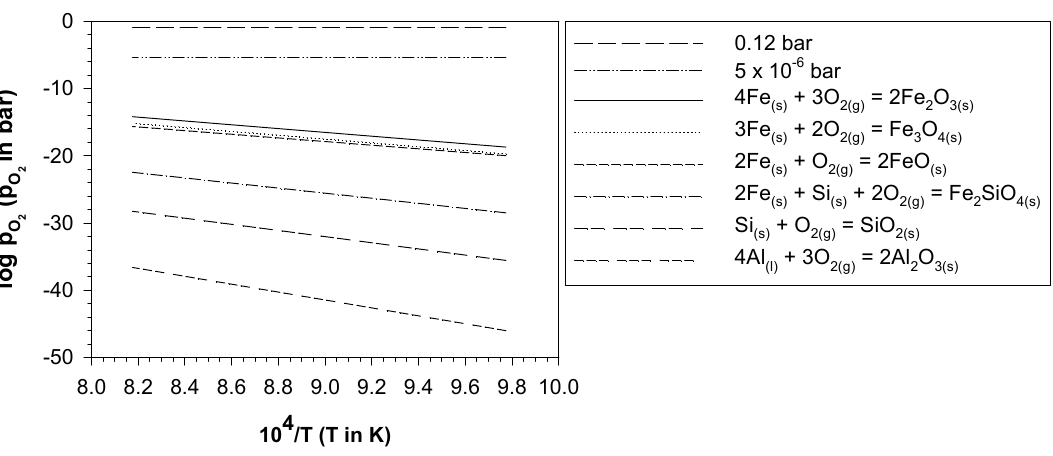
Figure 9. Equilibrium diagram of the formation of oxides relevant to the present work constructed using thermodynamic data from Kubaschewski and Evans [48].